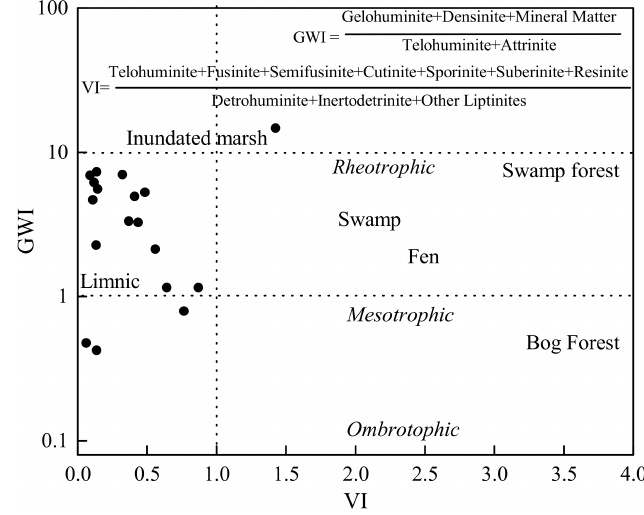
Figure 8. Plots of VI and GWI (after [9]). Reproduced with permission from Kalaitzidis et al.; published by